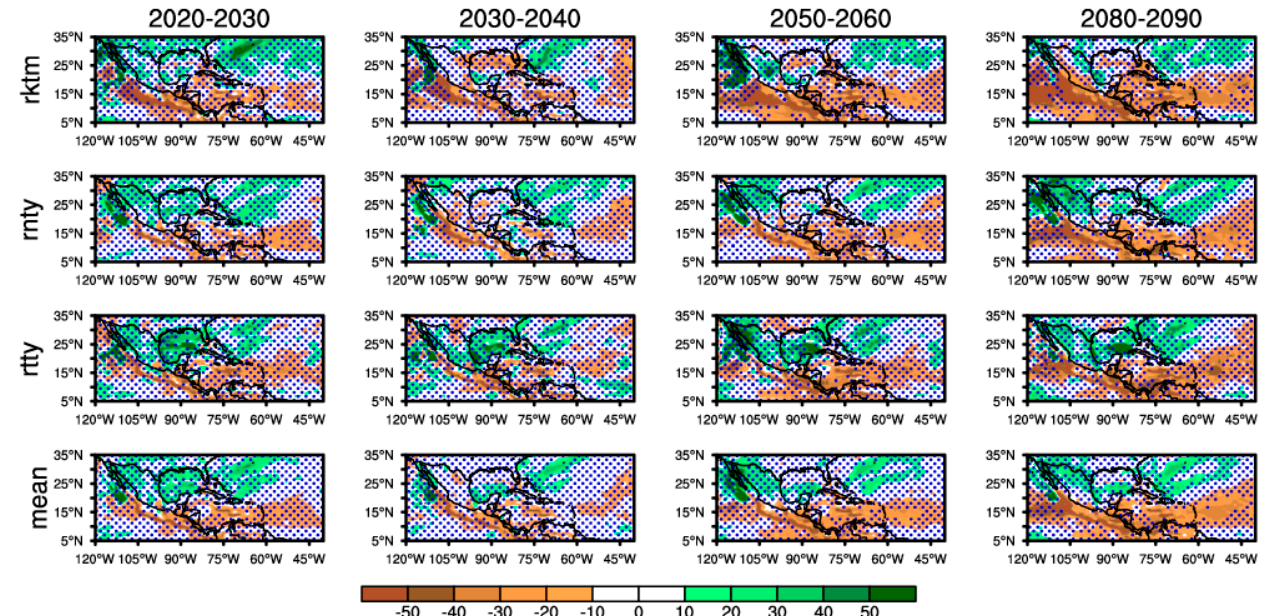
Figure 3. Mean annual percent change (%) in accumulated precipitation from May to November, defined as summer rainfall, with respect to the reference period (1990–2000). The dotted regions indicate a 95% significance level applying the Kolmogorov–Smirnov two-sample test .